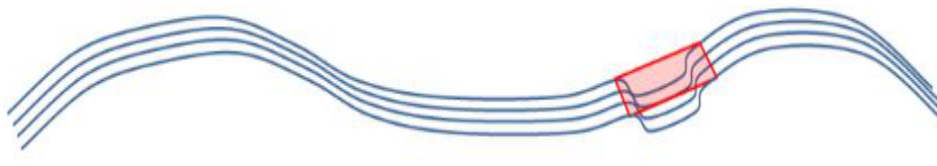
Figure 5. The Fall-block of the Slider.